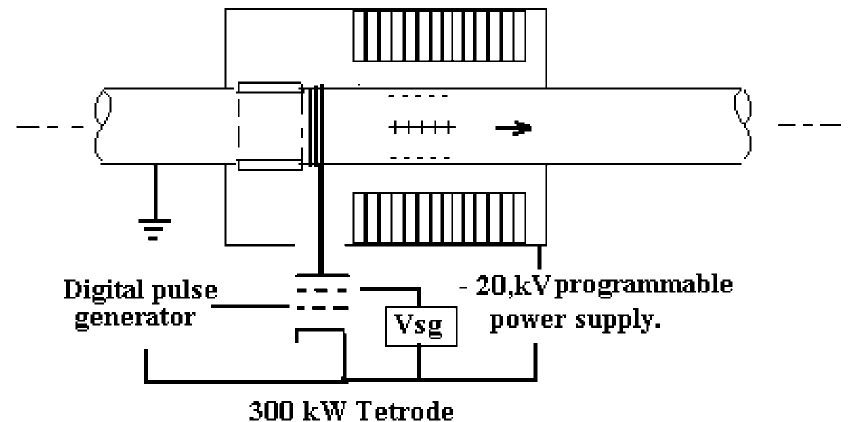
FIG. 12. In the design of the future Fermilab proton driver, the beam linear charge density is monitored and fed into a tetrode, which supplies the same charge density to the downstream end of the cavity gap. Thus the transient beamloading voltage is